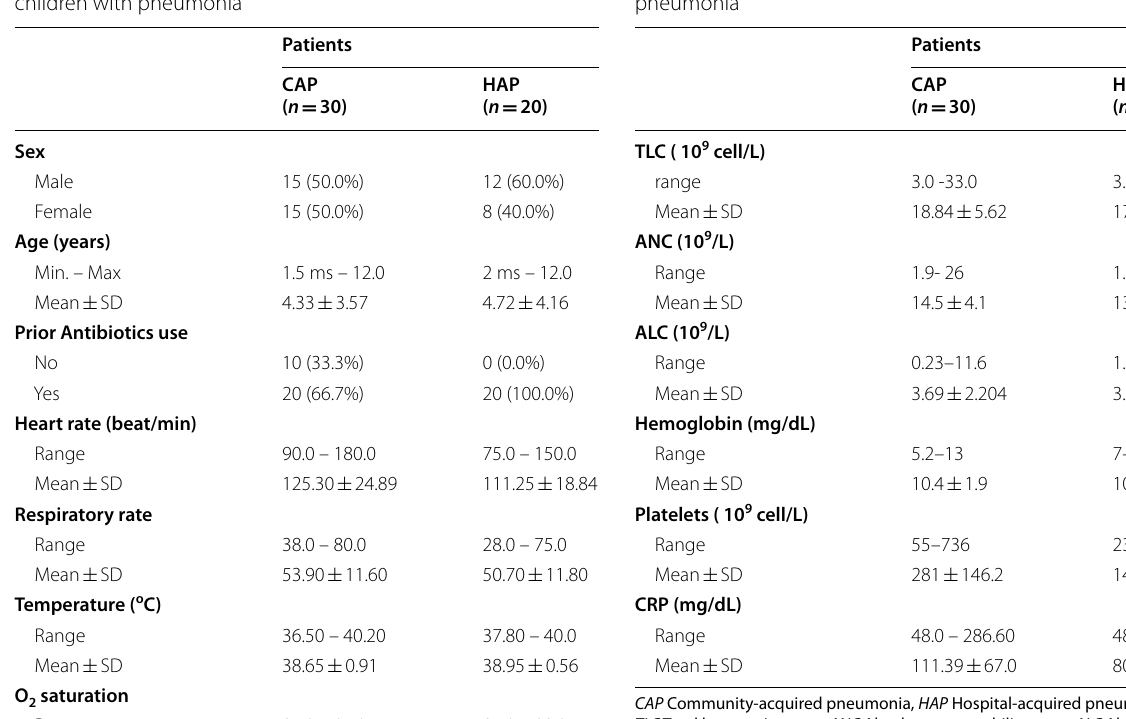
Table 2 Laboratory characteristics of Egyptian children with